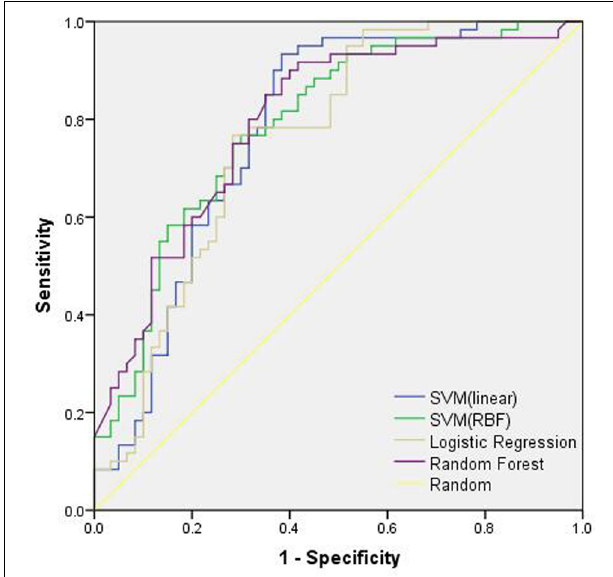
FIGURE 3 | The ROC curves of different classification models. SVM, support vector machine.